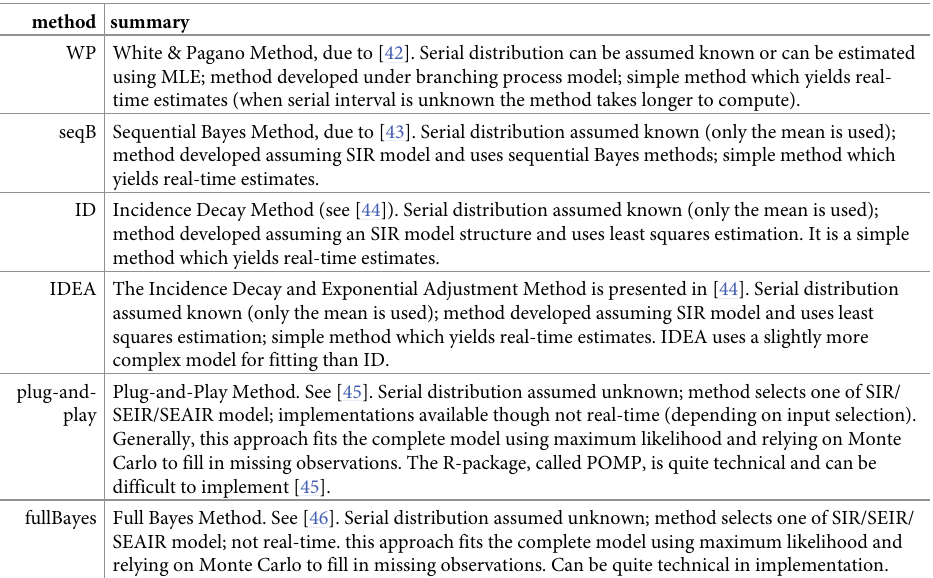
Table 2. Summary of estimation methods for R 0 . method